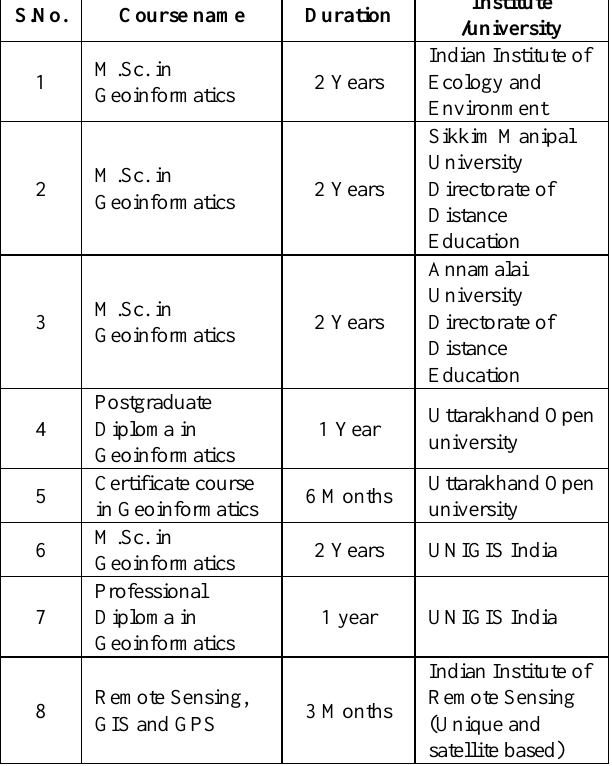
Table 1: Distance Education Programs in India